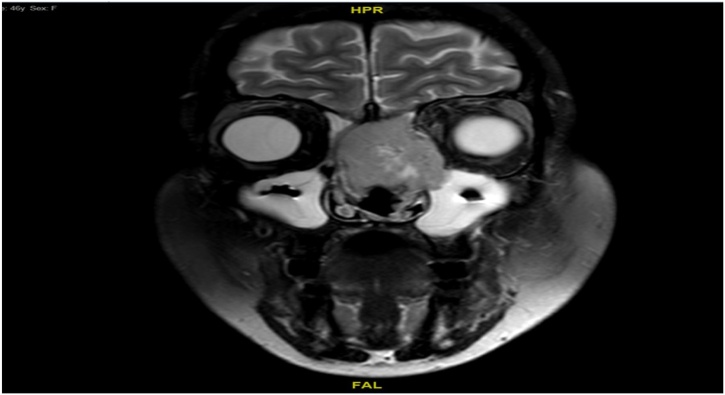
Preoperative MRI T2.